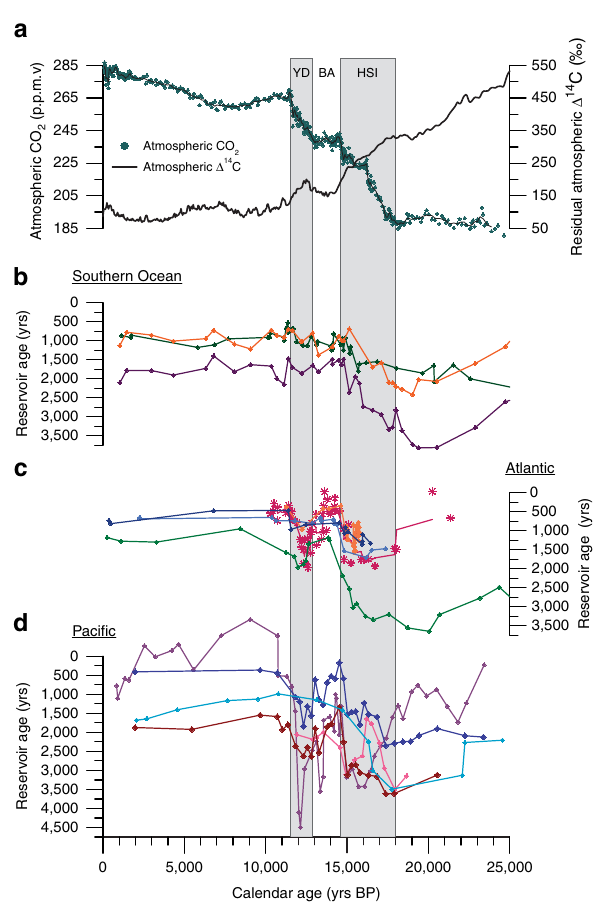
Figure 7 | Inter-ocean comparison of shallow and deep water ventilation. ( a ) An Antarctic ice core compilation of Atmospheric CO 2 (ref. 65) indicates increasing CO 2 during the deglacial coeval with declining Atmospheric D 14 C (corrected for natural production) 6,46 . ( b ) Southern Ocean records include surface (dark-orange) and deep (3,770m; dark purple) water depths from core MD07–3076 (ref. 13) in the